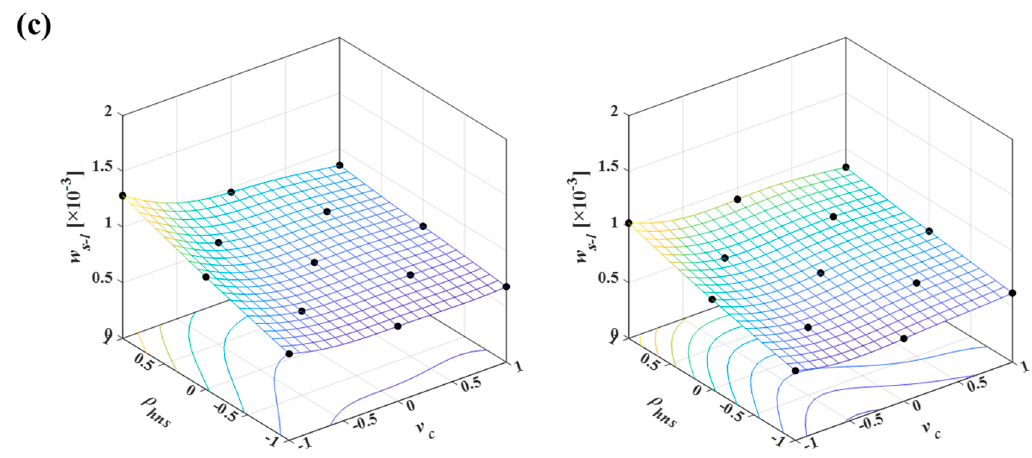
Figure 9. Three-dimensional contour of the prediction model of ( a ) streamwise propagation velocity, ( b ) transverse propagation velocity, and ( c ) averaged HNS mass fraction at sea level.